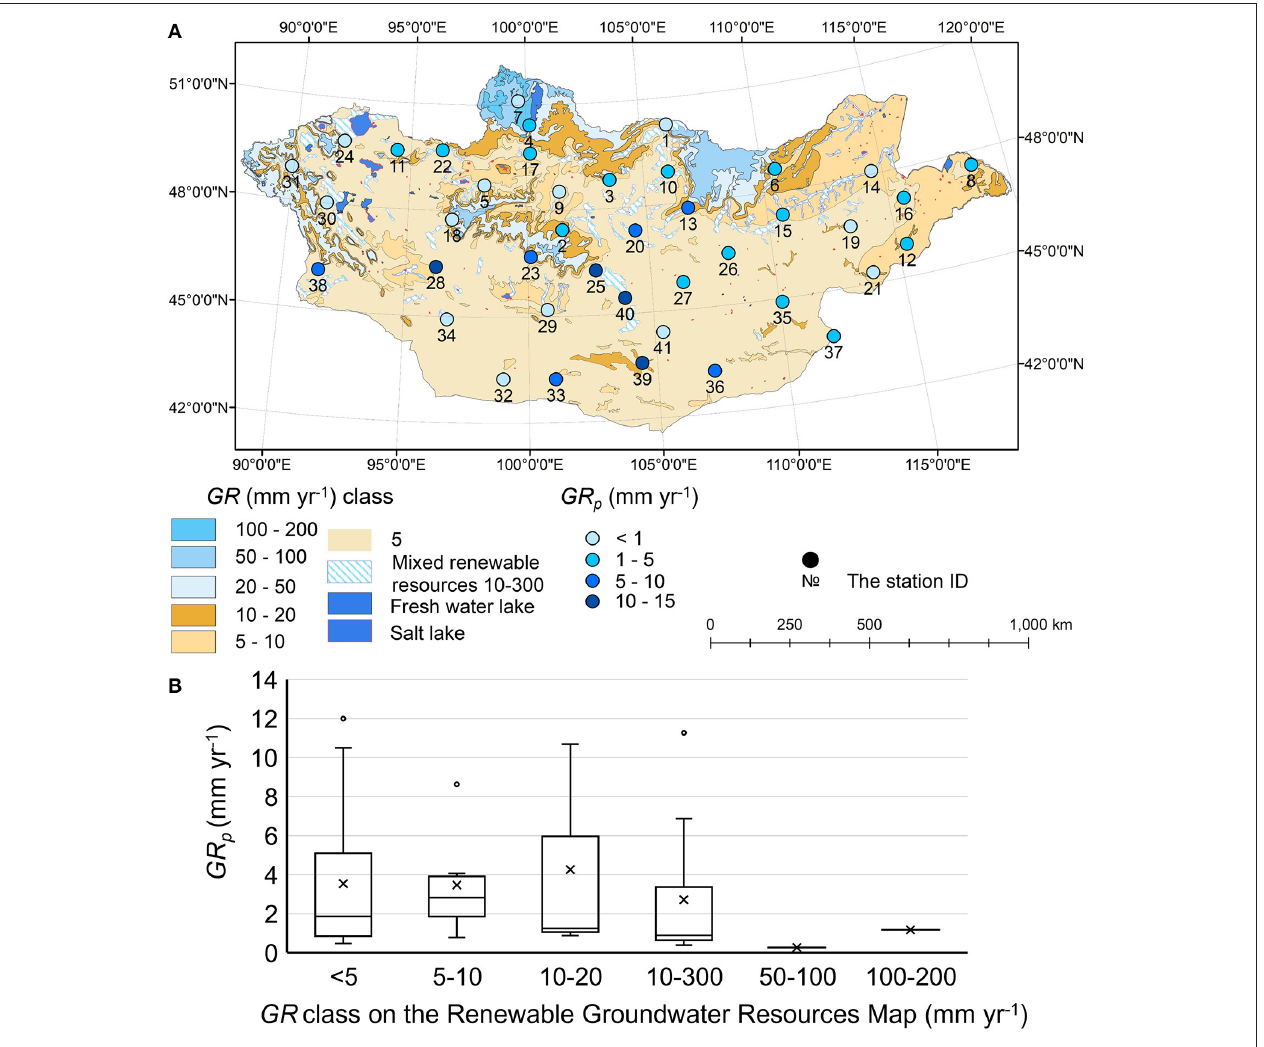
FIGURE 4 | GR statistics: (A) mean annual potential groundwater recharge (GR p ) simulated in HYDRUS-1D (black dots) on the Renewable Groundwater Resources Map grouped in GR p classes; (B) boxplots (box delimited by the two quartiles and vertical bars indicate the range between the 10th and 90th percentile) of mean annual potential groundwater recharge (GR p ) simulated in HYDRUS-1D by considering GR p classes. Mean values are indicated by the cross symbol, while outliers are depicted by the